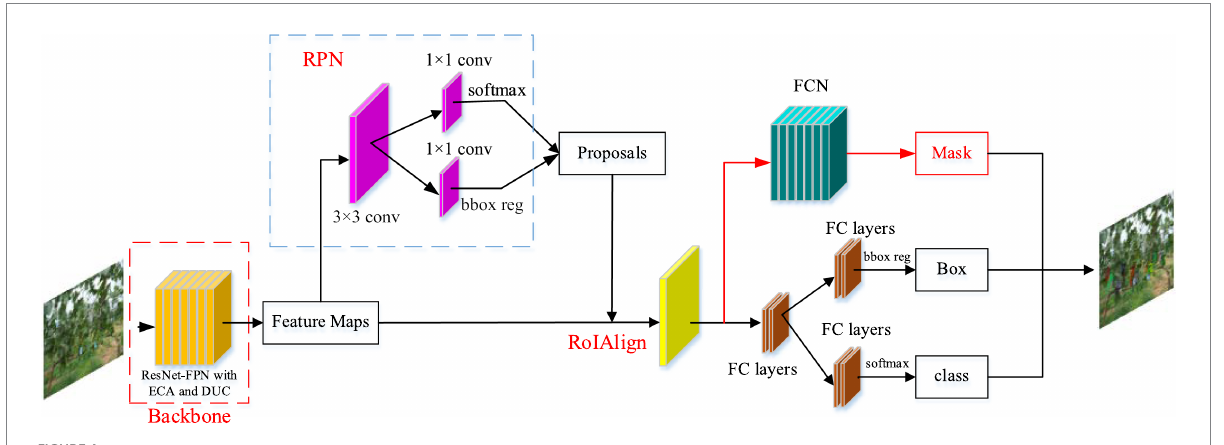
FIGURE 4 Structure of grape cluster instance segmentation network based on improved Mask